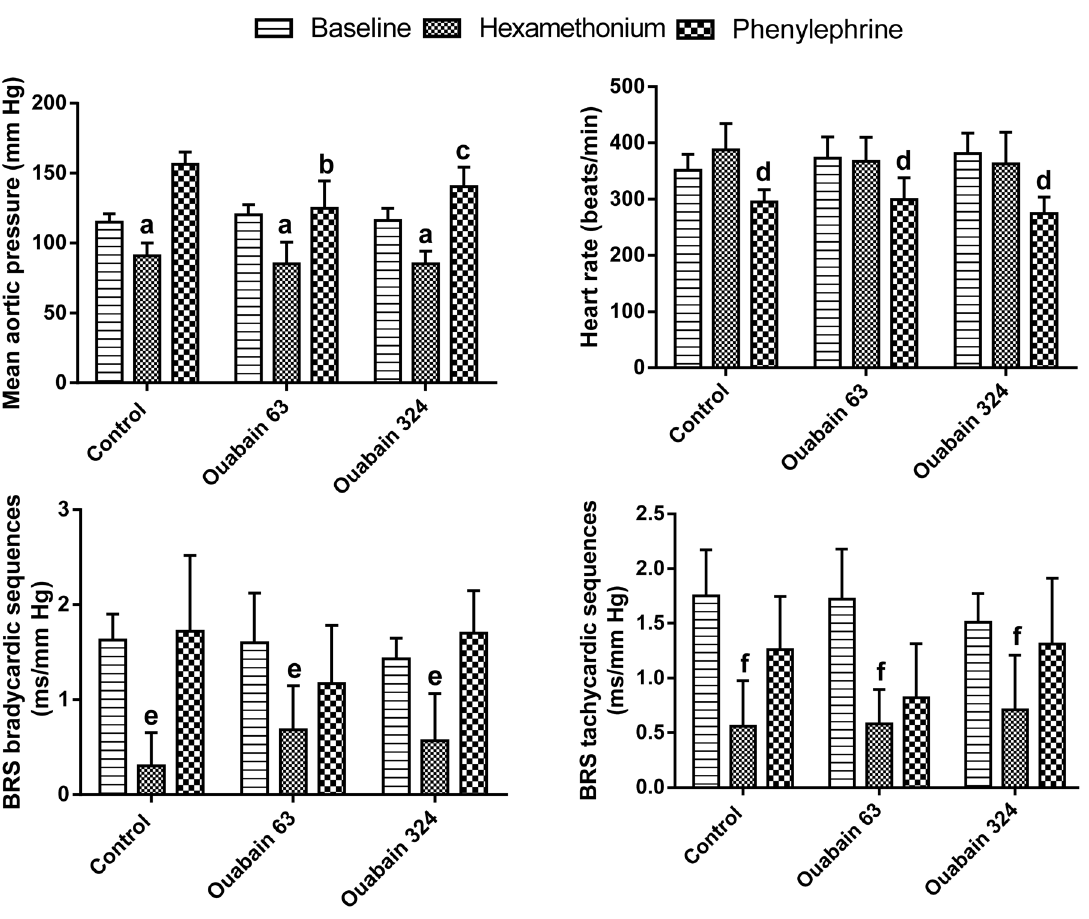
Figure 3. Hemodynamic effects of ganglionic blockade and a 1-adrenergic stimulation. The columns represent the mean values of 3 minute-long intervals before the injection of hexamethonium bromide (30 mg/kg s.c.), i.e., baseline and during the maximum blood pressure response (i.e., between ca. the 12 th –15 th min after the application of hexamethonium and between ca. the 27 th –30 th min after the administration of phenylephrine hydrochloride (3 mg/kg s.c.)); the vertical bars denote the 95% confidence intervals; n=10 rats. Control, pharmacological test performed before the implantation of the ouabain pellets; Ouabain 63, test performed when rats were treated for 21 days with 63 m g ouabain/kg/ day; Ouabain 324, test applied to rats treated for 40 days with 63 m g ouabain/kg/day and then for 21 days with 324 m g ouabain/kg/day. The data were analyzed with repeated measures MANOVA and the multivariate Wilk’s test in a 3 (ouabain treatment) x 3 (pharmacological intervention) design followed by the contrast and trend analysis; a, significant contrast analysis ‘‘baseline’’ versus ‘‘hexamethonium,’’ F 1,9 =40, P=14.10 2 5 ; b, significant contrast analysis ‘‘control‘‘ versus ‘‘ouabain 63’’ after phenylephrine, F 1,9 =21.7, P=0.0012; c, significant contrast analysis ‘‘control‘‘ versus ‘‘ouabain 324’’ after phenylephrine, F 1,9 =5.1, P=0.0508; d, significant contrast analysis ‘‘hexamethonium’’ versus ‘‘phenylephrine’’, F 1,9 =29, P=44.10 2 5 ; e, significant contrast analysis ‘‘baseline’’ versus ‘‘hexamethonium’’, F 1,9 =16.1, P=27.10 2 5 . Baroreflex sensitivity - tachycardic sequences: interaction F 4,6 =1.3, P=0.359; main effect ‘‘ouabain treatment’’, F 2,8 =0.44, P=0.658; main effect ‘‘pharmacological intervention’’, F 2,8 =24.1, P=41.10 2 5 ; f, significant contrast analysis ‘‘baseline’’ versus ‘‘hexamethonium’’, F 1,9 =53.6, P=45.10 2 6